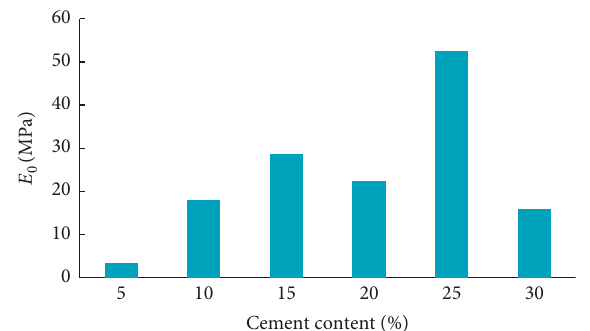
0 of slurry with various cement